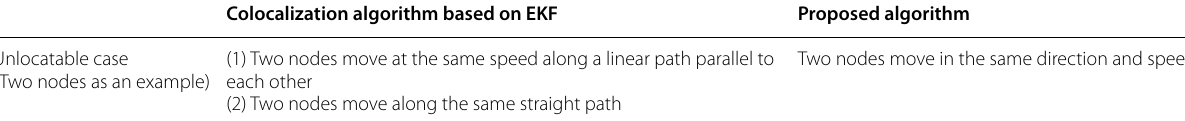
Table 3 Algorithm localizability condition comparison Colocalization algorithm based on EKF Proposed algorithm